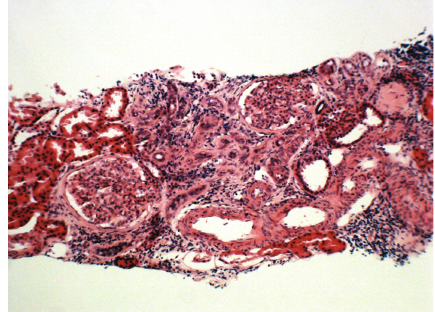
Figure 2: High-power haematoxylin- and eosin-stained renal bio- psy after completion of antituberculous treatment shows tubuloin- terstitial fibrosis in the absence of caseating